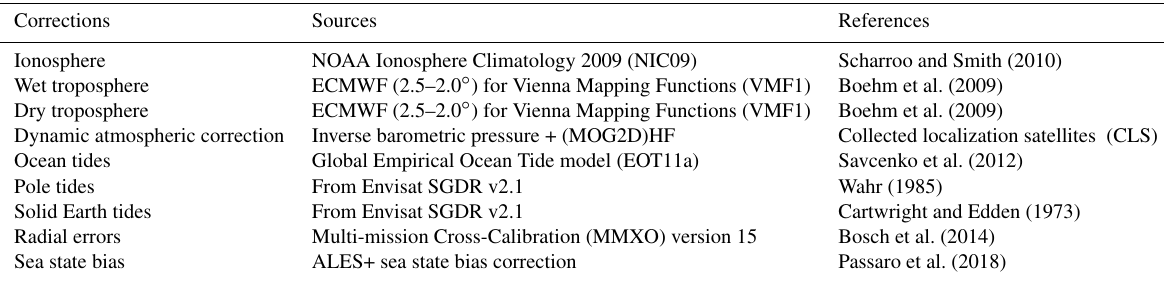
Table 1. Geophysical and empirical altimetry corrections applied in the